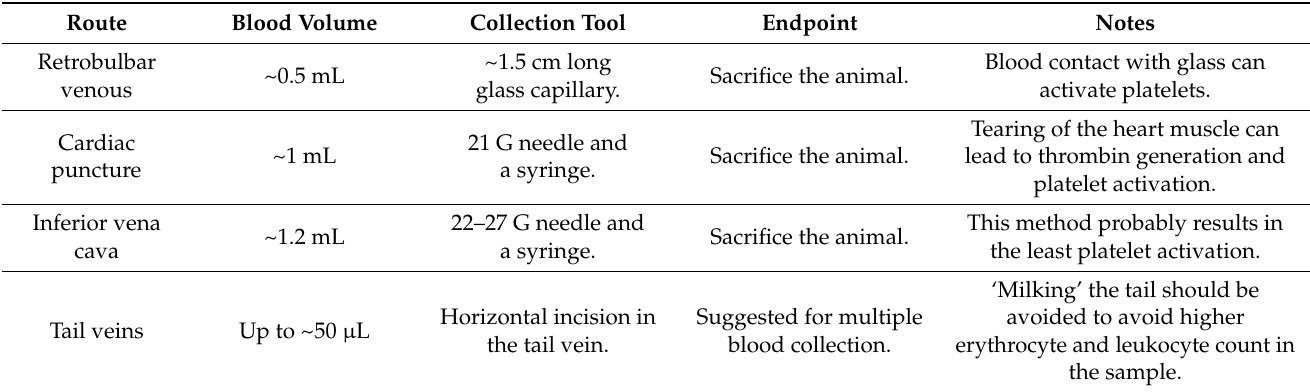
Table 1. Different blood collection routes from mice.